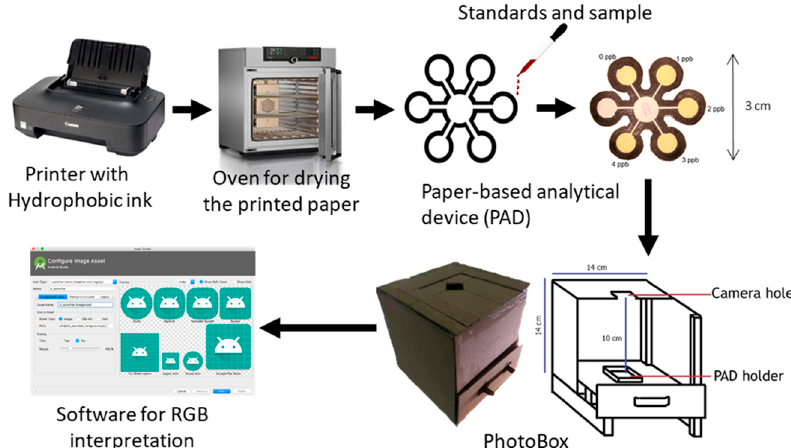
Figure 4. Schematic of the paper-based analytical device (PAD) preparation and digital image acquisition for mercury ion determination. As with the colorimetric sensor, silver nanoparticles were embedded on the PAD before sample addition. Each piece of PAD paper contains standards and a sample.